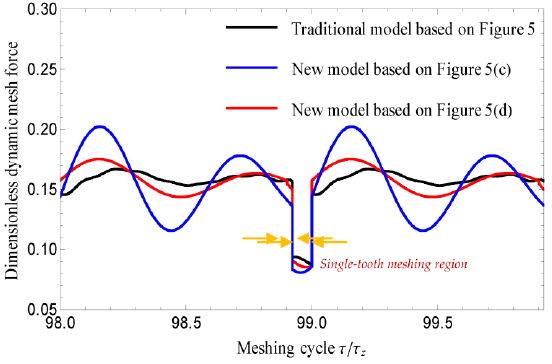
Figure 7. Comparative analysis of total dynamic mesh force based on traditional and new model.